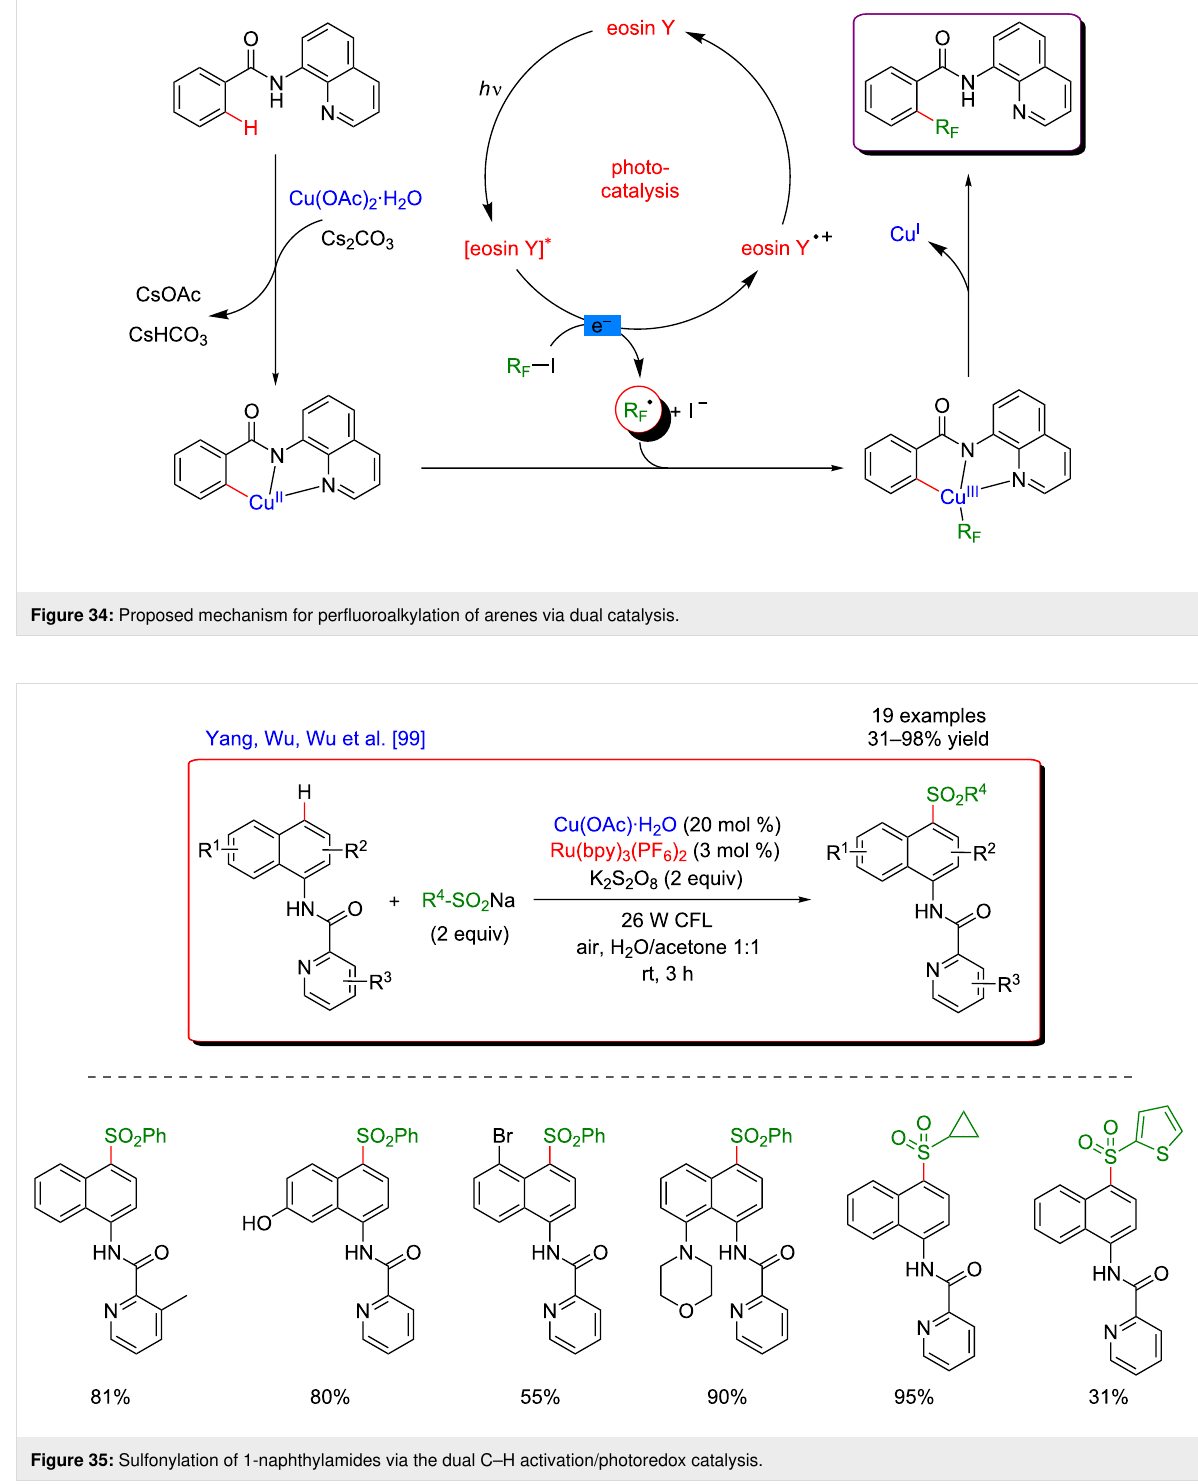
metal catalysts, one able to activate a poorly reactive C–H bond and the second one harvesting the light in a photoredox